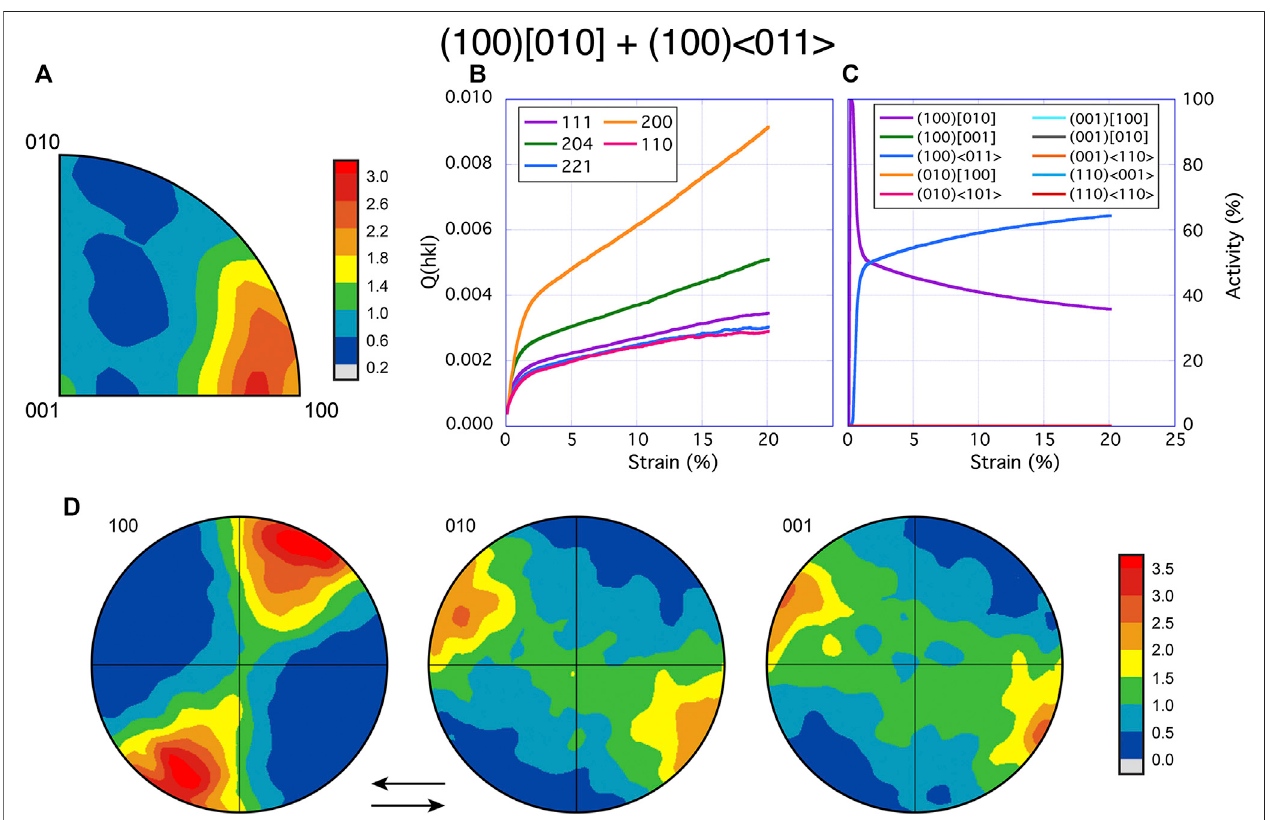
FIGURE 6 | Model results for the slip systems pair (100)[010] and (100) 〈 011 〉 . The results of elasto-viscoplastic self-consistent (EVPSC) modeling are shown in (A – C) . Panel (A) shows texture with color scales of the inverse pole fi gure (compression direction) giving multiples of random distribution. Q ( hkl ) and slip system activity areshown inplot (B) and (C) ,respectively.VPSC modelswererunwiththesame criticalresolvedshearstressvaluesastheEVPSCmodel andpole fi guresareshownin (D) . The sense of shear is top to the left. The activity of all but (100)[010] and (100) 〈 011 〉 is < 1% at all conditions.